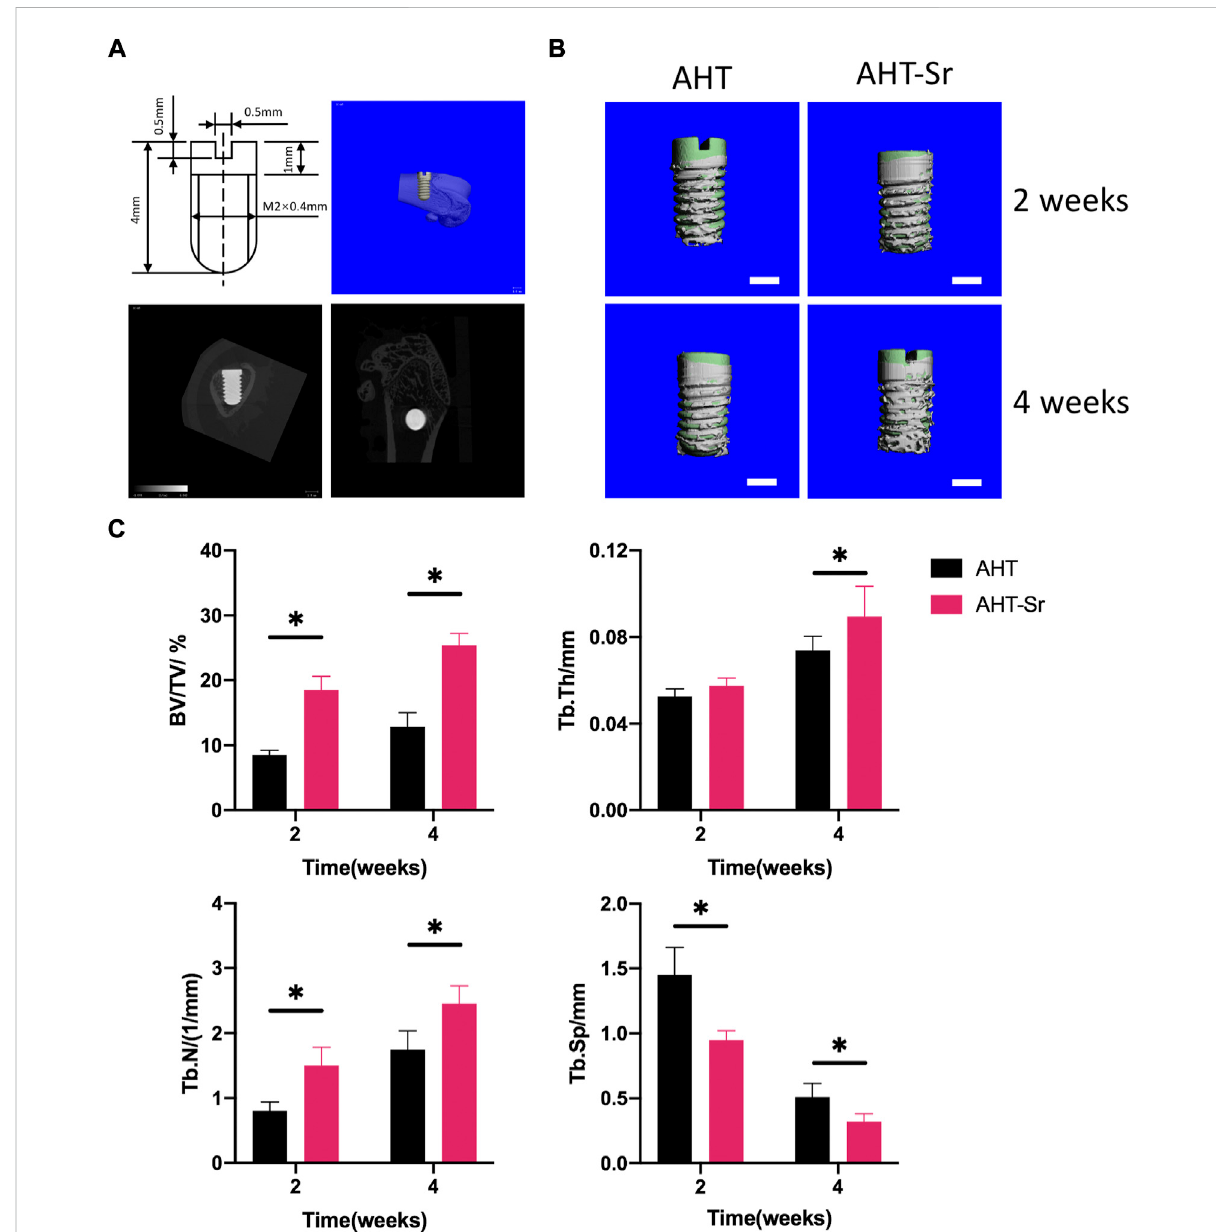
FIGURE 6 Osseointegration of AHT and AHT-Sr implants was measured by micro-CT. (A) Schematic of the surgery. (B) Reconstructed pictures of AHT implants (Control) and AHT-Srimplants at2and 4 weeks post surgery. Scale barrepresenting 1 mm; n =5per group. (C) BV/TV, Tb.Th,Tb.N, and Tb. Sp were measured. n = 5. * p <